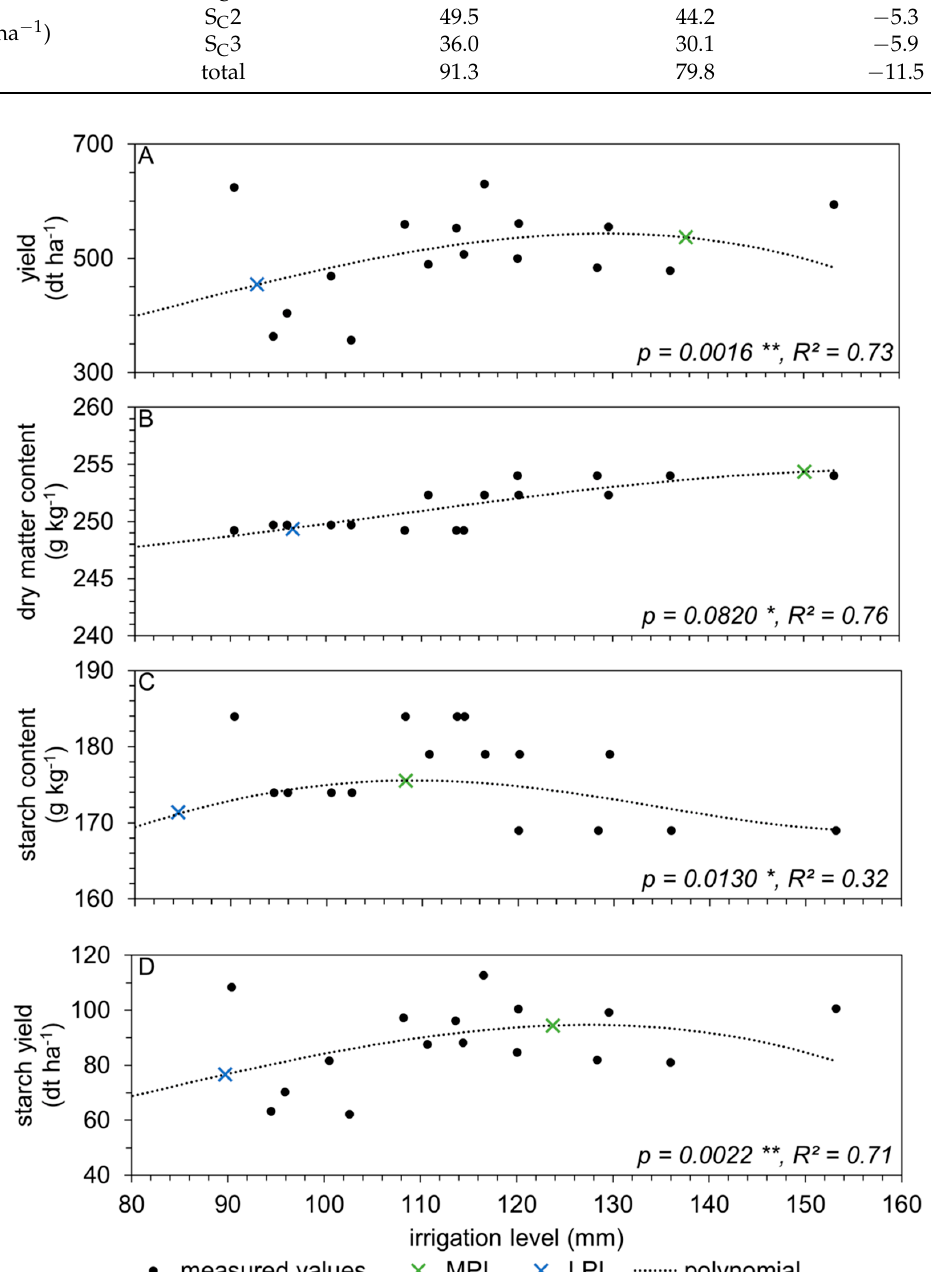
Figure 3. Yield and tuber quality of each harvest parcel (four harvest parcels per test plot) as a function of the irrigation level (mm). ( A ): total yield (dt ha − 1 ); ( B ): dry matter content (g kg − 1 ); ( C ): final starch content (g kg − 1 ); ( D ): total starch yield (dt ha − 1 ). Green dashed lines indicate the maximum profitable irrigation level (MPI). Blue dashed lines indicate the lowest profitable irrigation level (LPI), with regard to tuber quality thresholds. Level of statistical significance of each polynomial is indicated by * p ≤ 0.05, ** p ≤ 0.01. According to the polynomial order, there are local minima at higher irrigation levels than the MPI. These were not used for the LPI, as it must be lower than the MPI.